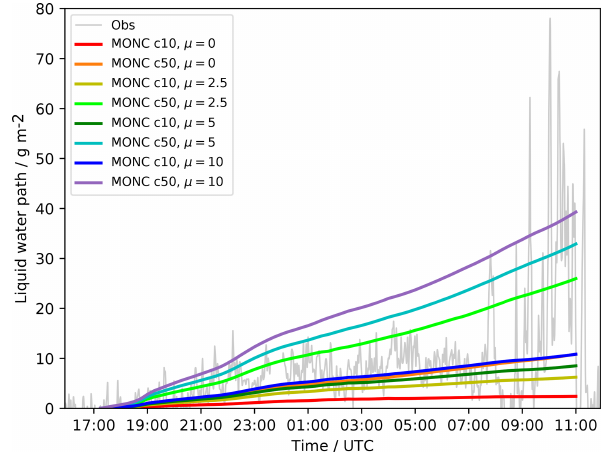
Figure 12. Liquid water path observed and modelled by MONC with low and high CDNC values, with varied values of the shape parameter µ (see